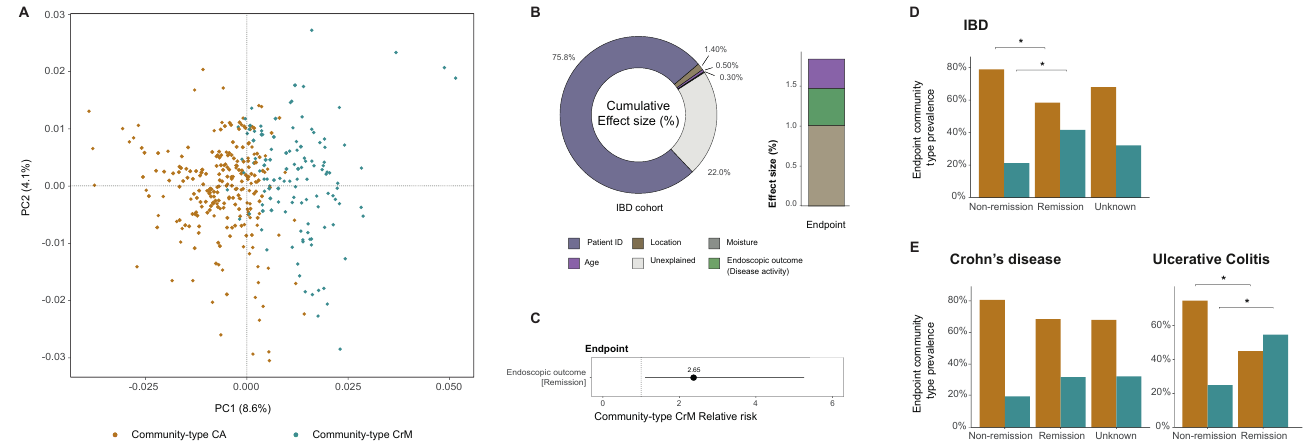
Figure 9. ( A ) Principal coordinates analysis of inter-individual differences of the gut virome (genus level Bray-Curtis dissimilarity) in the IBD cohort (circles colored by viral community-type, n = 366). ( B ) Metadata variables significantly correlating to virome compositional variation in both the IBD cohort (left) and post-intervention samples (right) (dbRDA, genus-level Bray-Curtis dissimilarity), as determined by a multivariate linear regression model. ( C – E ) Modeling the association between the metadata drivers of post-intervention samples and the prevalence of viral community-type CrM (logistic regression, n = 166, only significant associations shown). ( C ) Relative risk ratio of prevalence of viral community-type CrM with the significant driver (endoscopic remission) of virome variation. ( D ) Representation of viral community-type prevalence in post-intervention samples ( n = 166) stratified according to the endoscopic outcome (non-remission, remission, unknown). ( E ) Representation of viral community-type prevalence in post-intervention samples per IBD subtype, CD (left, n = 115) and UC (right, n = 51) stratified according to the endoscopic outcome (non- remission, remission, or unknown). * p < 0.05 (adjustment for multiple testing was performed using the Benjamini-Hochberg